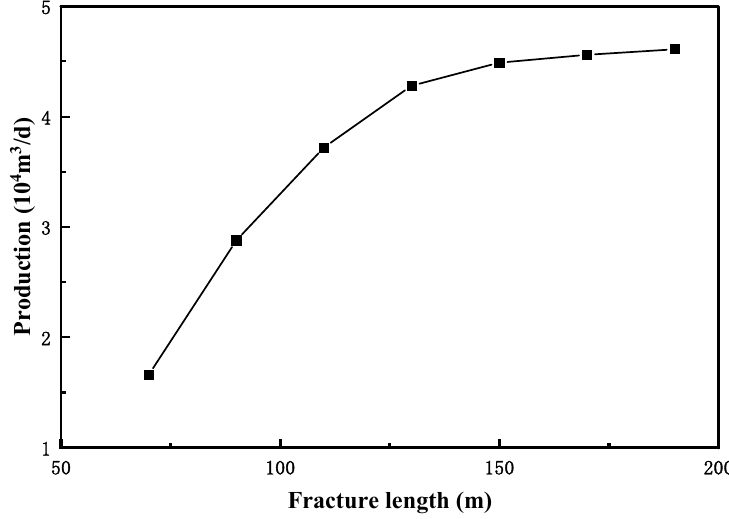
Figure 15. Production curve after fracturing at different fracture lengths.